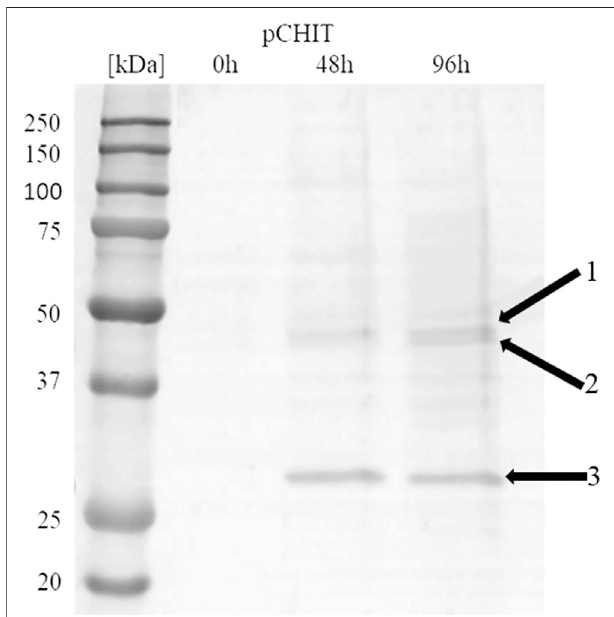
FIGURE 6 | Electrophoretic analysis (SDS-PAGE) of proteins present in the after-culture medium obtained after culturing selected KM71H_pCHIT transformant. Arrows indicate following expressed proteins: 1 — recombinant chitin deacetylase ChDaII from Mucor circinelloides IBT-83 enriched with an 18 amino acid fragment of P2A sequence M w ∼ 48 kDa; 2 — recombinant chitinase from T. lanuginosus enriched with a 17 amino acid fragment of T2A sequence M w ∼ 46 kDa; recombinant chitosanase from A. fumigatus